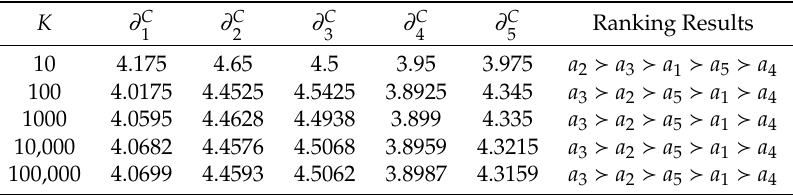
Table 8. Ranking results based on di ff erent parameter K .